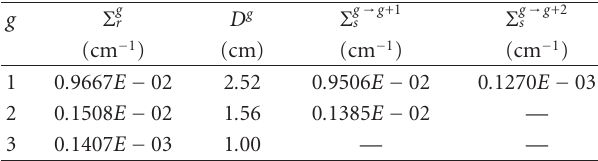
Table 3: Cross-sections for the reflector in the heterogeneous case.